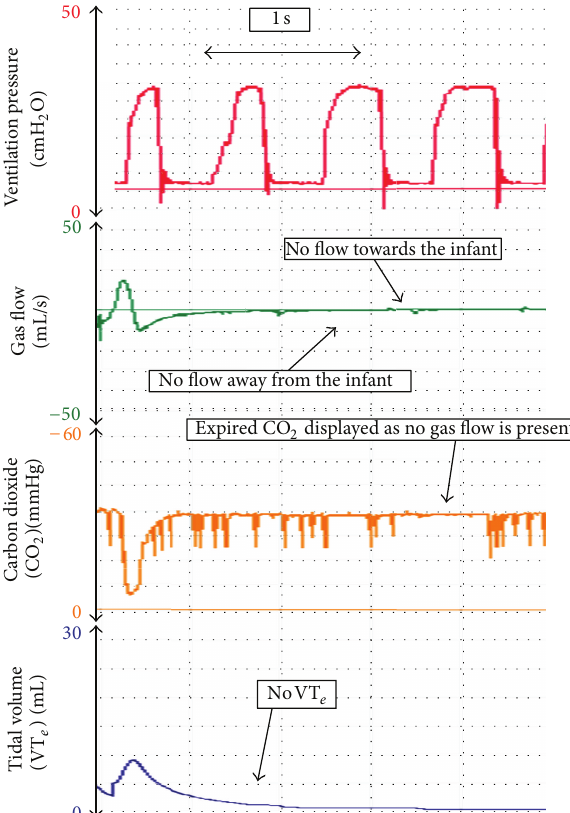
Figure 3: During PPV, the ETT suddenly becomes obstructed, which can be identified by gas flow and 𝑉 𝑇 cessation. Airway pressures are continuously delivered.